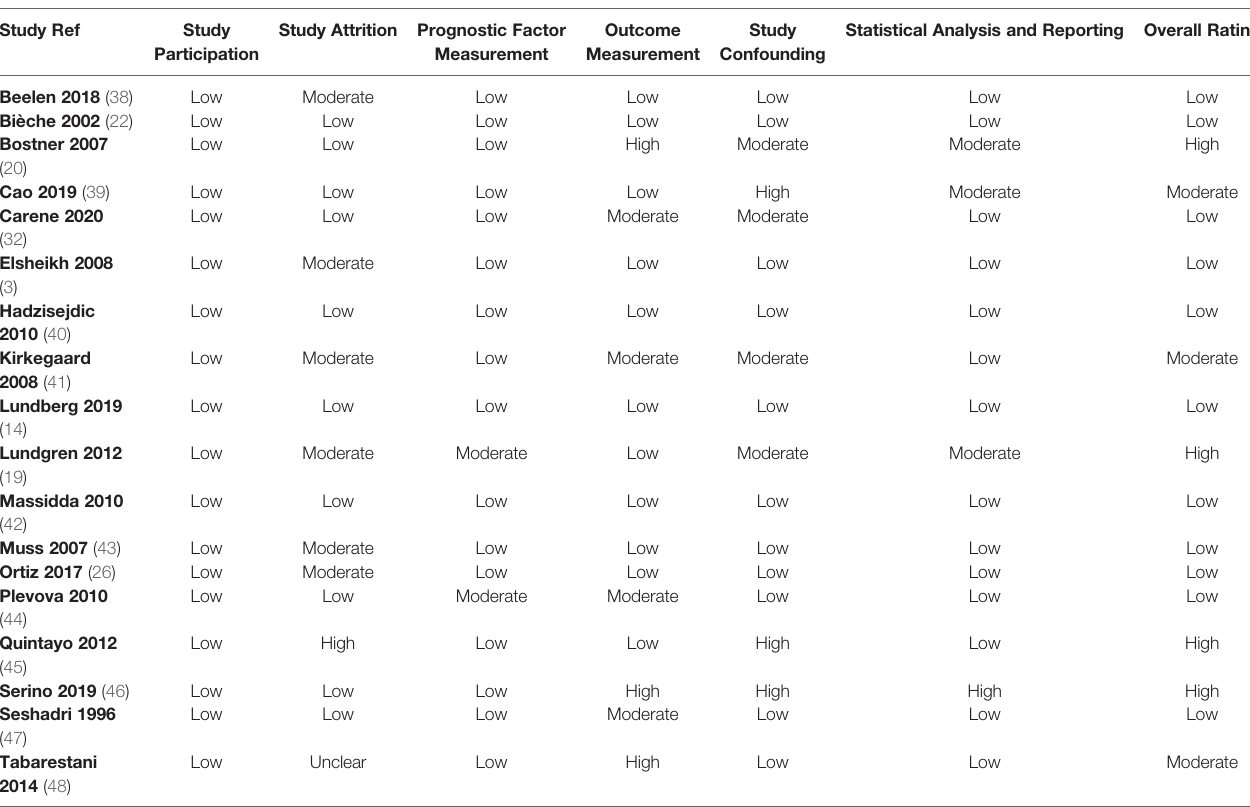
TABLE 1 | Quality Assessment of Eligible Studies. Study